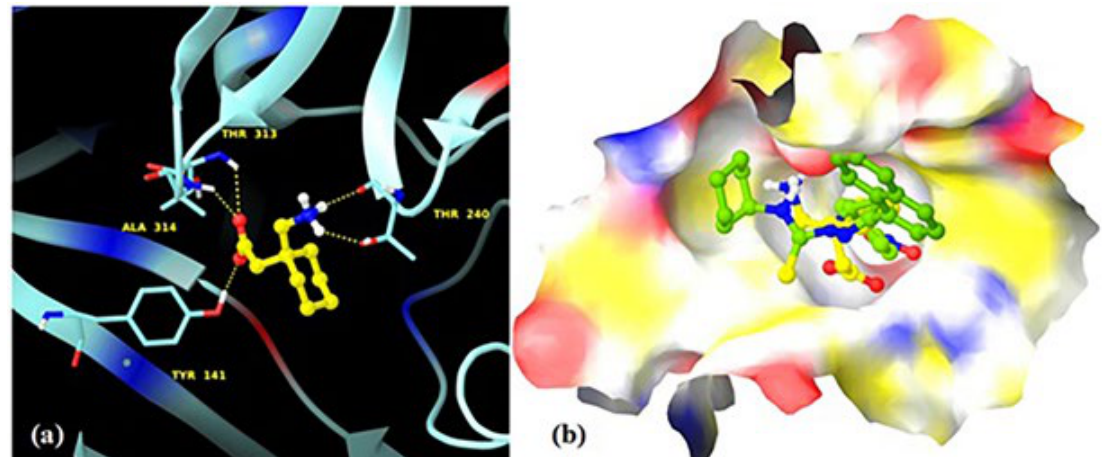
FIGURE 3 - (a) Docked Pose of co-crystal, gabapentin (yellow colour) represented as ball and stick in the binding site of hBCATc showing hydrogen bond interaction (yellow dash lines) (b) A receptor surface of s uperimpose gabapentin (yellow colour) with 4e (yellow green colour) in the binding site of hBCATc.